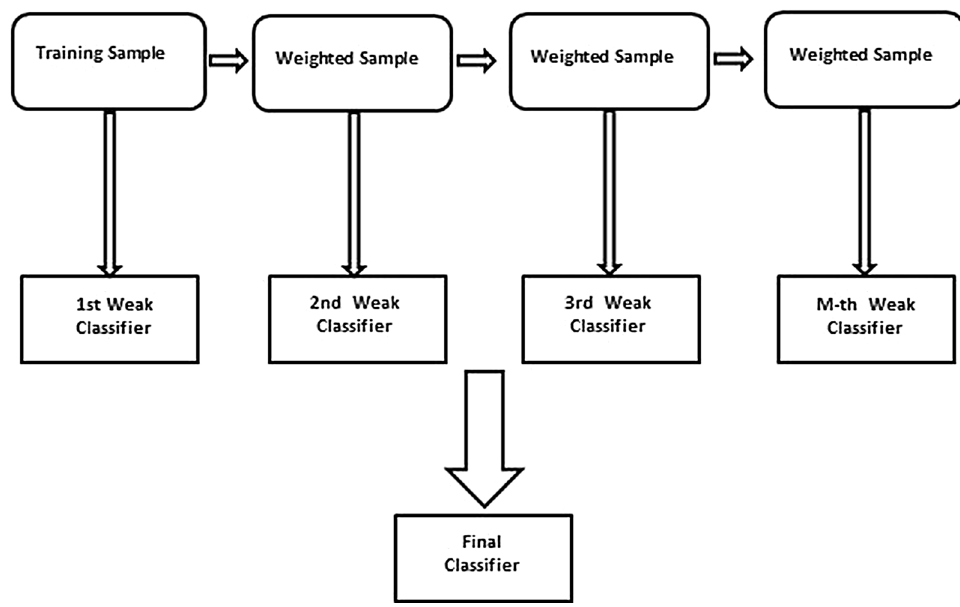
Figure 2. Simple architecture of XGB.